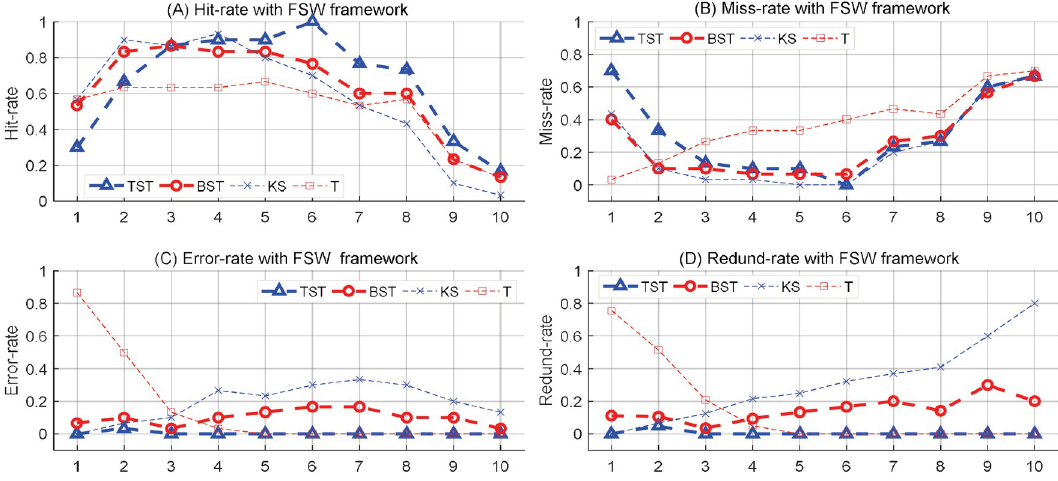
Fig 5. The results of MCPs detection by using TST, BST, KS and T methods in the FSW framework. For the synthetic sample with predefined 30 t MCPs, the trend analyses are illustrated in chart (A) Hit-rate, (B) Miss-rate, (C) Error-rate, and (D) Redund-rate, under different sizes of Nw from 2^6 to 2^15,